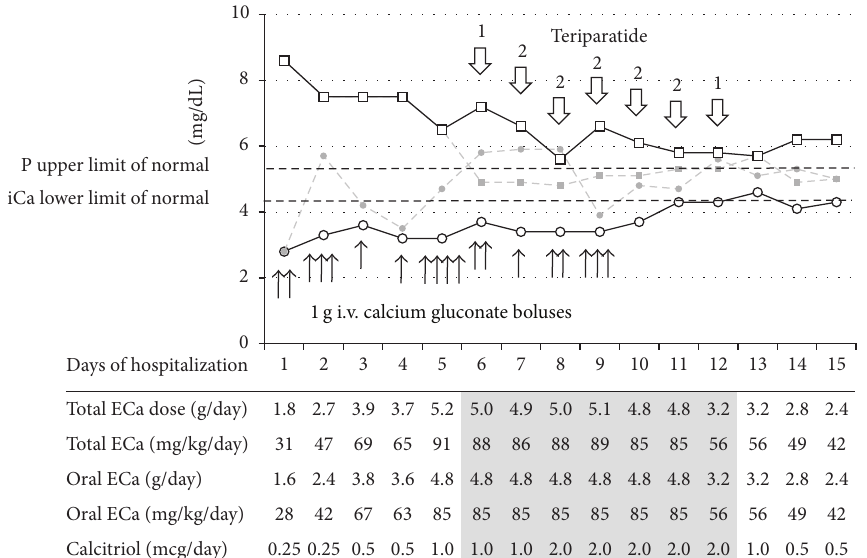
Figure 2: Trends in serum ionized calcium and phosphorus levels in a 12-year-old girl with hypoparathyroidism over the course of hospitalization. Minimum and maximum daily levels of iCa (circles and solid and dashed lines, resp.) and P (squares and dashed and solid lines, resp.) are shown. Black arrows indicate individual calcium gluconate boluses (1g each). Open arrows point to days of subcutaneous administration of teriparatide with the numbers above the arrows indicating once daily (1) or twice daily (2) injections. Oral supplementation consisted of calcium carbonate except for Days 2-3 when calcium citrate was also given. ECa, elemental calcium.